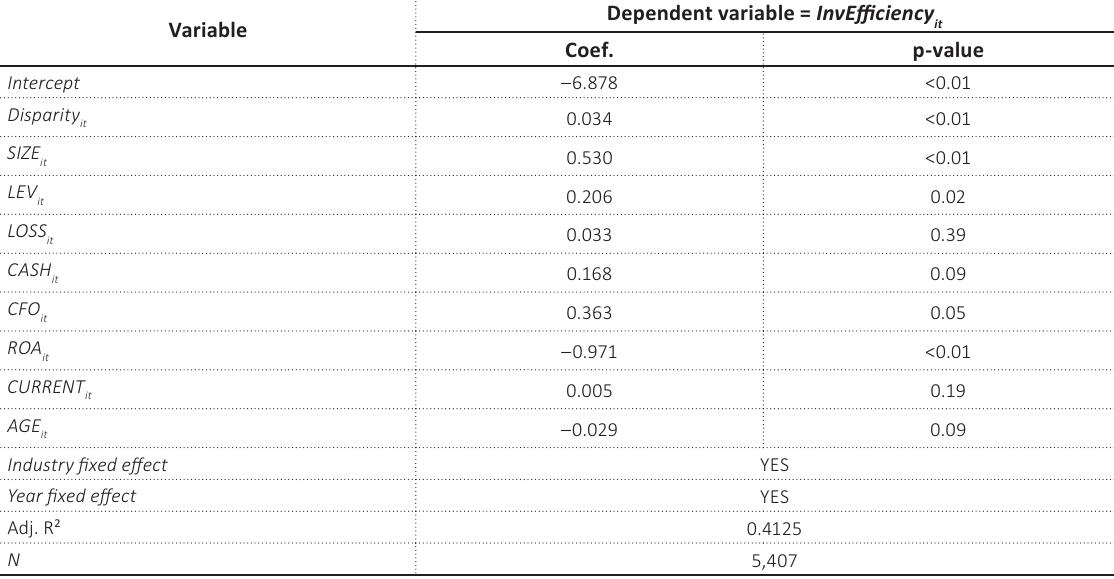
Table 3. Pay disparity and a firm’s investment